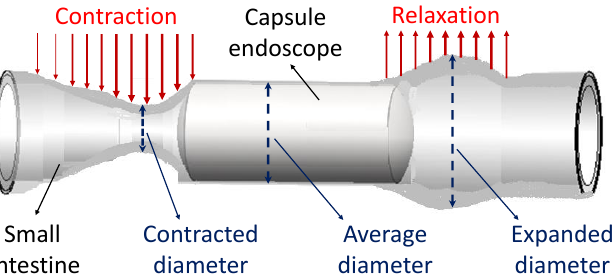
Figure 2. Conceptual model of a small intestine showing peristaltic forces on a capsule endoscope. The peristaltic cycle results in a range of diameters, which are illustrated and labelled for this study.